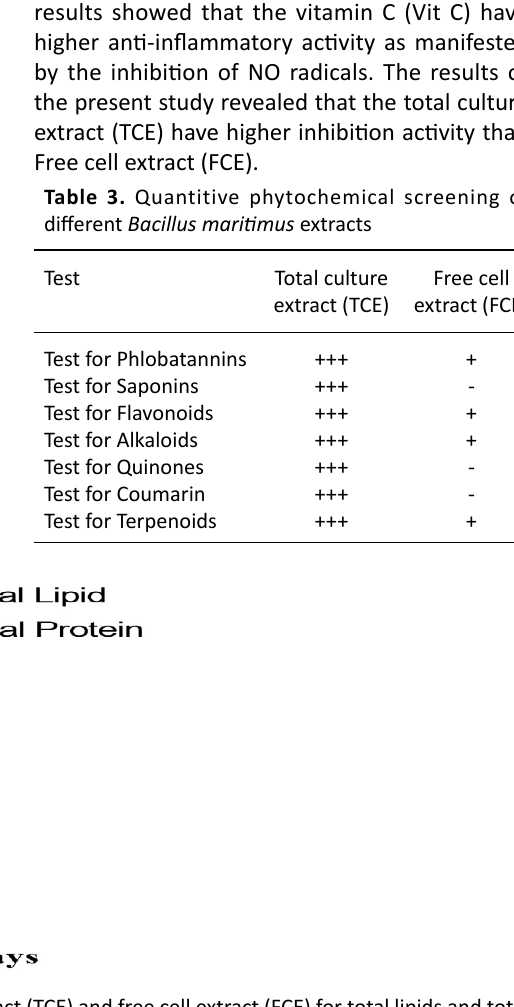
Fig. 4. The phytochemical analysis of total culture extract (TCE) and free cell extract (FCE) for total lipids and total